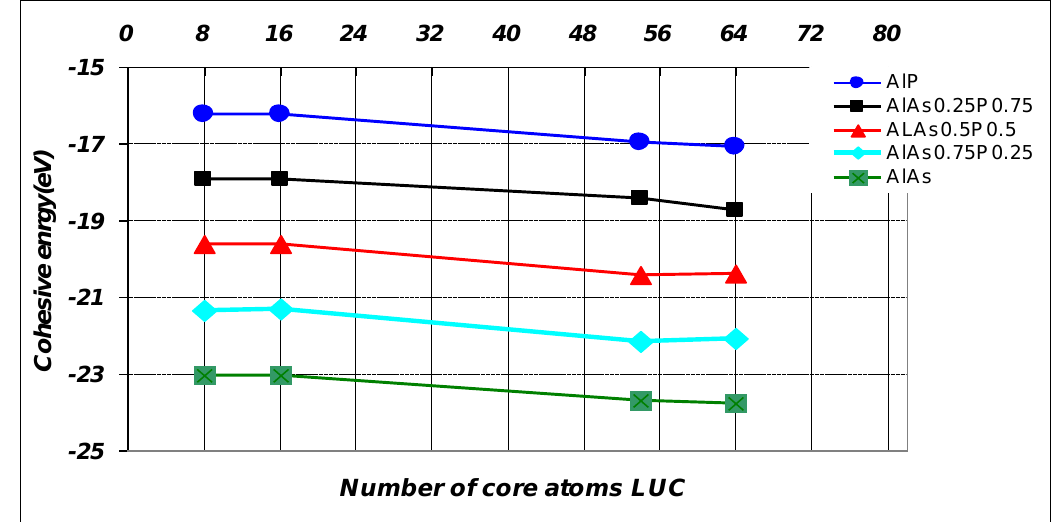
Fig.4: Cohesive energy of Al As